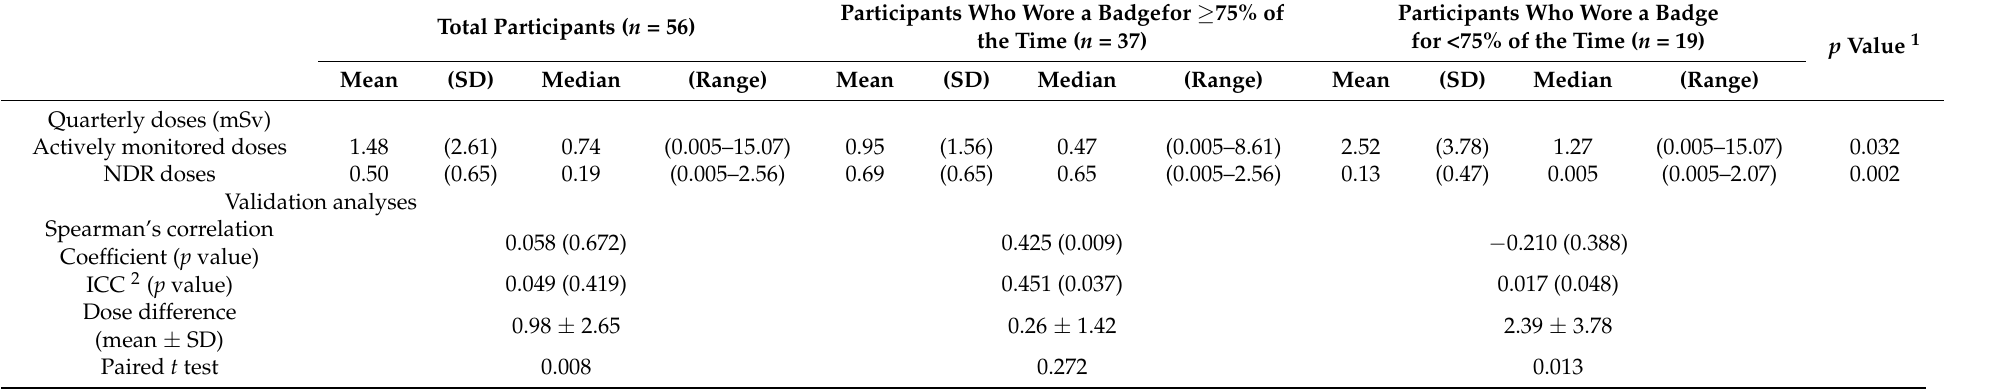
Table 2. Comparison of actively monitored doses and the KCDC (Korea Centers for Disease Control and Prevention) NDR (national dose registry) doses (Hp (10)) for interventional radiologists during a quarter in